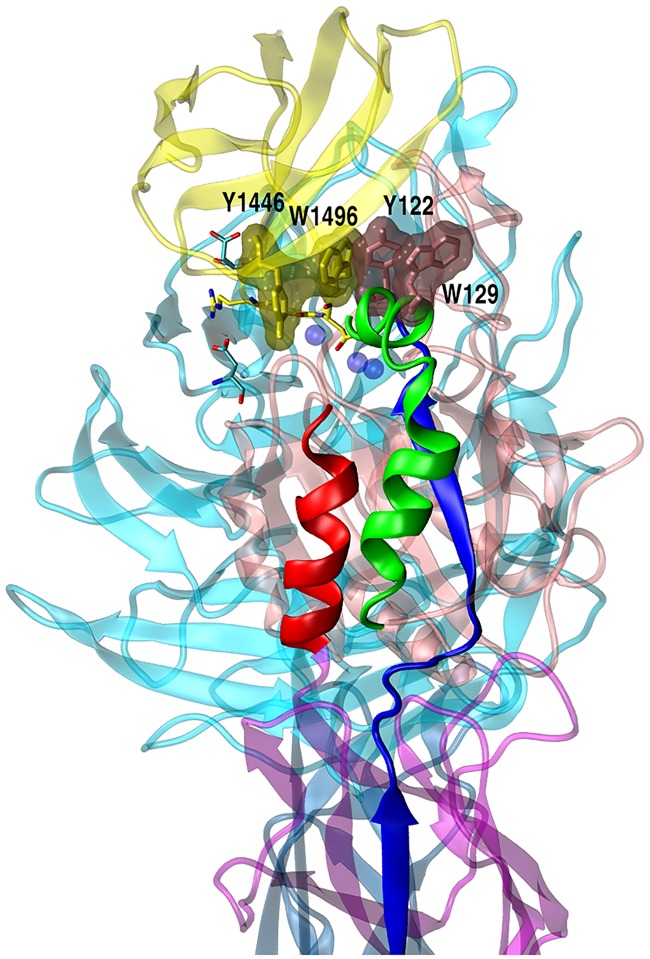
Close-up view of hFN10 complex.Important structural elements are indicated: α1 (green), α7 (red), strand β5 (blue). Mn2+ are displayed as transparent blue spheres. Ghost cartoons are used for αvβ3 (cyan and pink codes for αv and β3, respectively) and fibronectin (yellow). Ghost surface evidences W129β3, Y122β3, W1496FN and Y1446FN (from the right to the left). RGD-guanidinium and aspartic acids of the electrostatic clamp (namely D150αv and D218αv) are also indicated as sticks. Note that the solvent-exposed Y122β3 belongs to β5 strand (blue) that spans the whole β3 subunit (see main text).